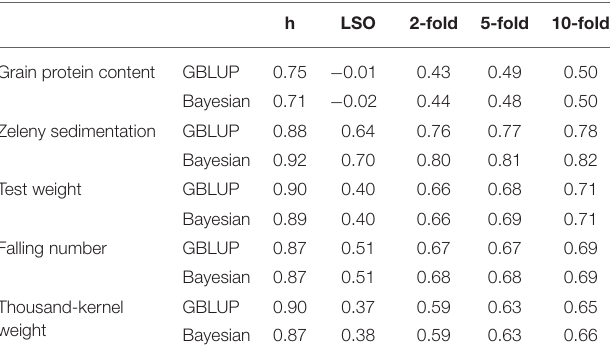
TABLE 6 | Comparison of predictive abilities based on GBLUP and Bayesian Power Lasso models. h LSO 2-fold 5-fold